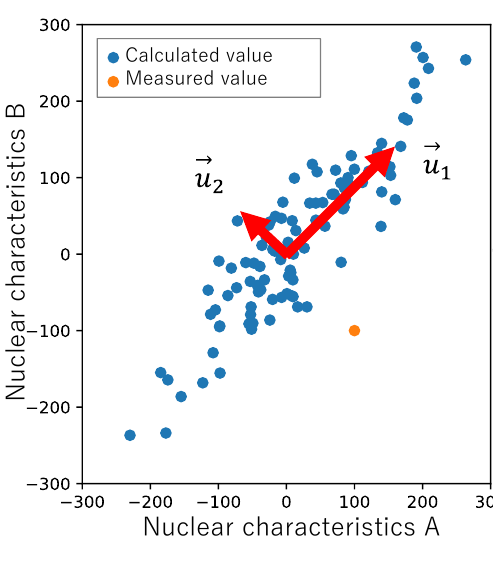
Fig.1 The concept of weights